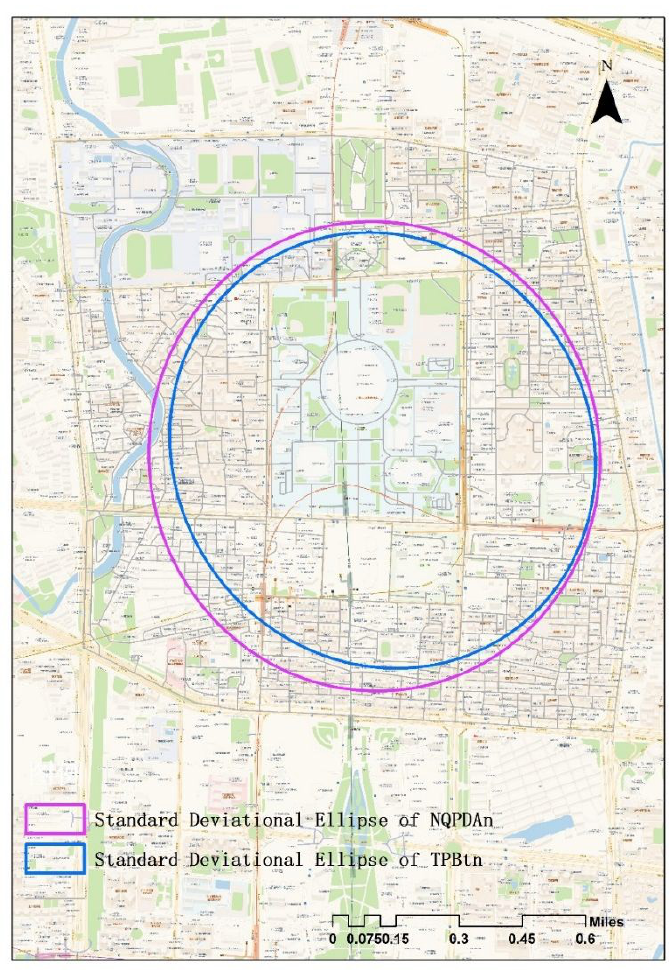
Fig. 2 Standard deviation ellipse of global closeness degree and global betweeness